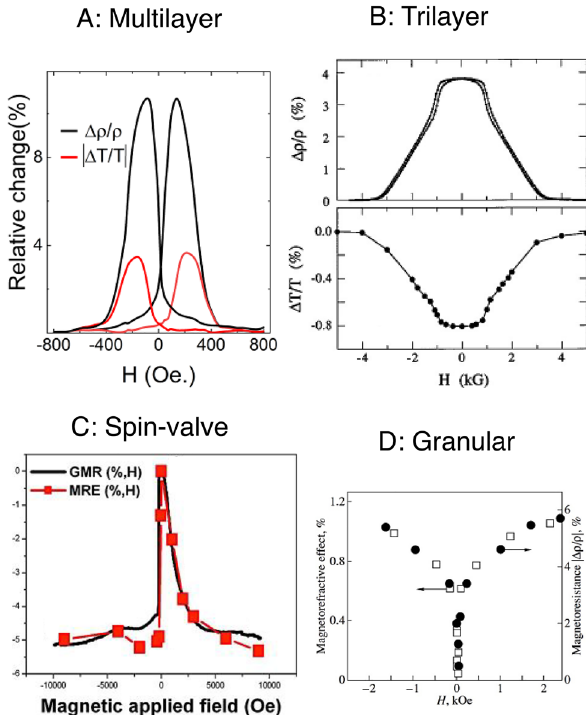
Figure 4: Magnetic field dependence of magneto-transport and corresponding MRE in different types of spintronic